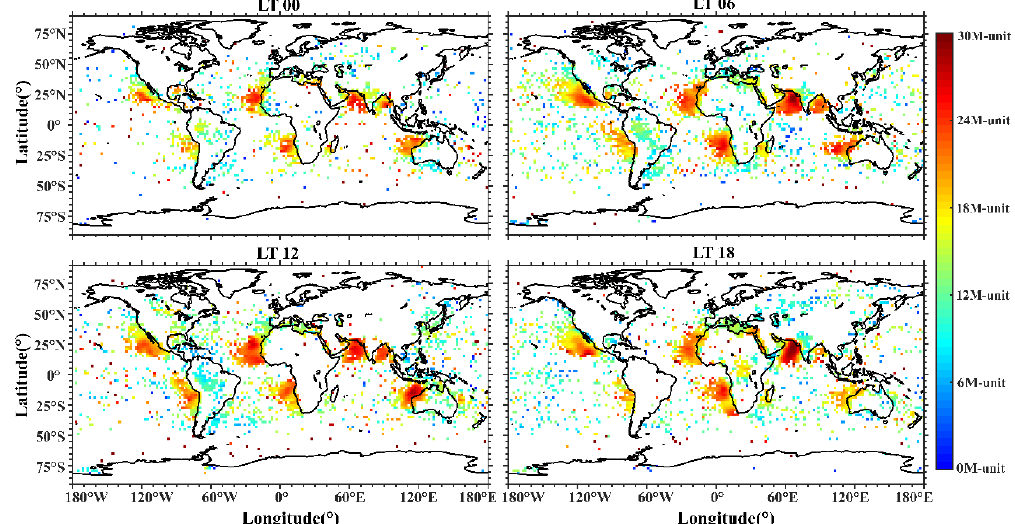
Figure 10. Distribution of the trapping layer intensity with local time variations. The blank grids represent that there is no trapping layer event.